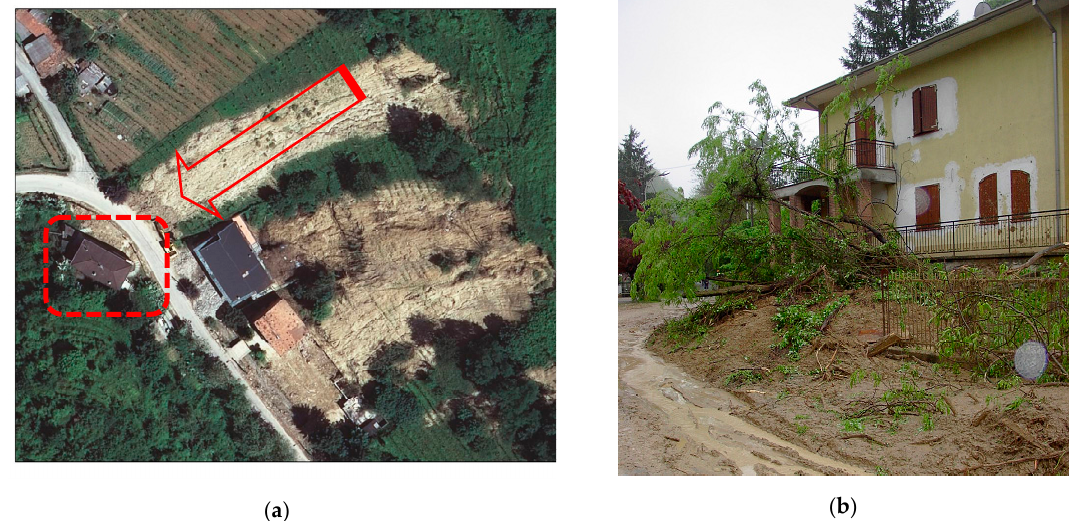
Figure 1. Rainfall-induced landslide occurred on April 2009 in the Recoaro valley of the Oltrepò Pavese: ( a ) Plan view with the sliding direction (red arrow) and the downstream structure impacted by the landslide (dashed red square), the aerial photograph of the area was taken by Ditta Rossi s.r.l. (Brescia, Italy) on 18 May 2009; ( b ) Detail of the impacted structure showing part of the slide.